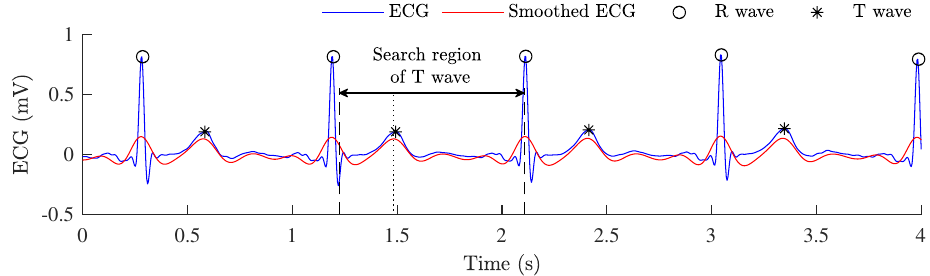
Figure 3. A low-complexity detection of T waves from the ECG signal by using additional